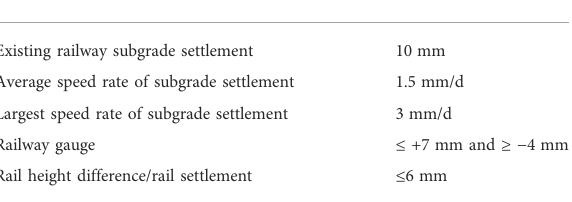
TABLE 1 Control value index of roadbed and rail of existing railway